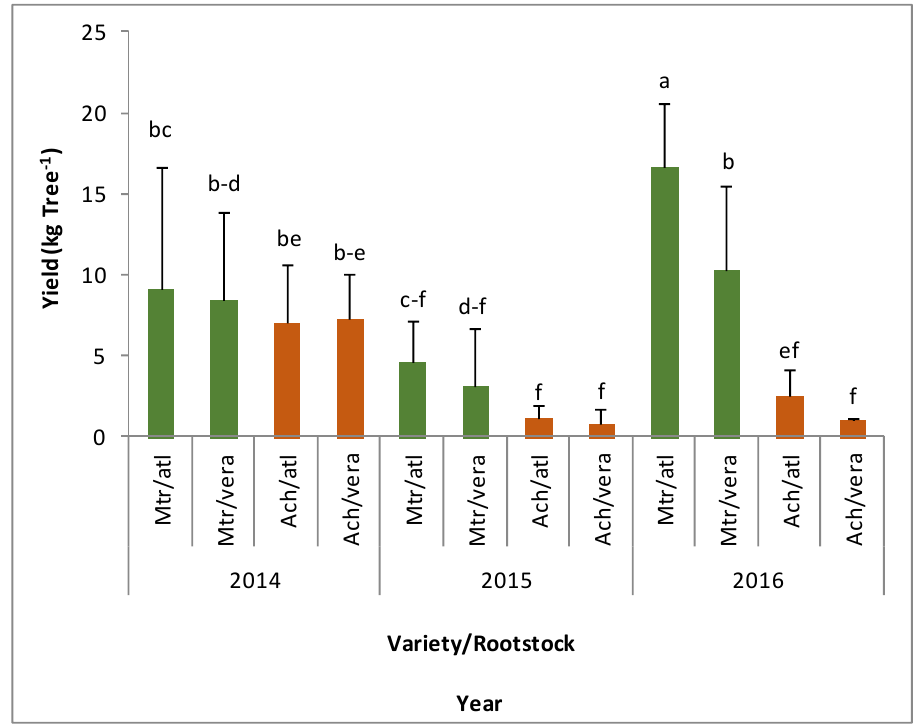
Figure 1. Effect of cultivar–rootstock interaction on annual fruit yield of pistachio. Mtr: Mateur; Ach: Achouri; atl: P. atlantica ; vera: P. vera ; Columns with the same letter are not significantly different (ANOVA, p ≤ 0.05). Table 2. Mean weights (g) of fresh fruit (FFW) and nut (NFW), dry weights of nut (NDW) and kernel (KDW), and nut dehiscence rate (DR) in percent